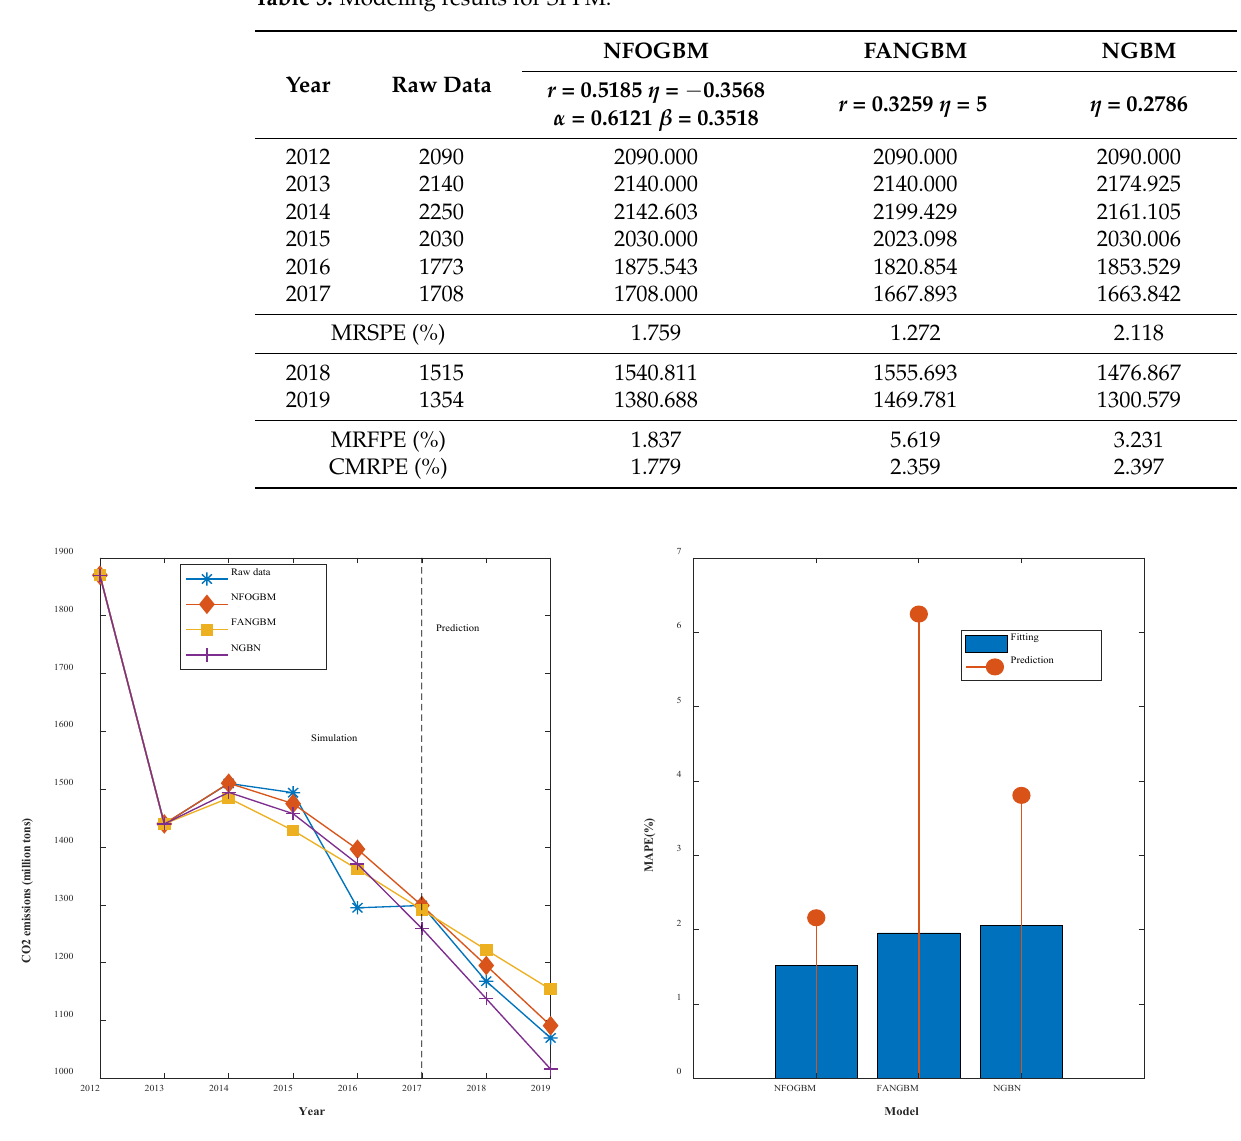
Table 5. Modeling results for SPFM.